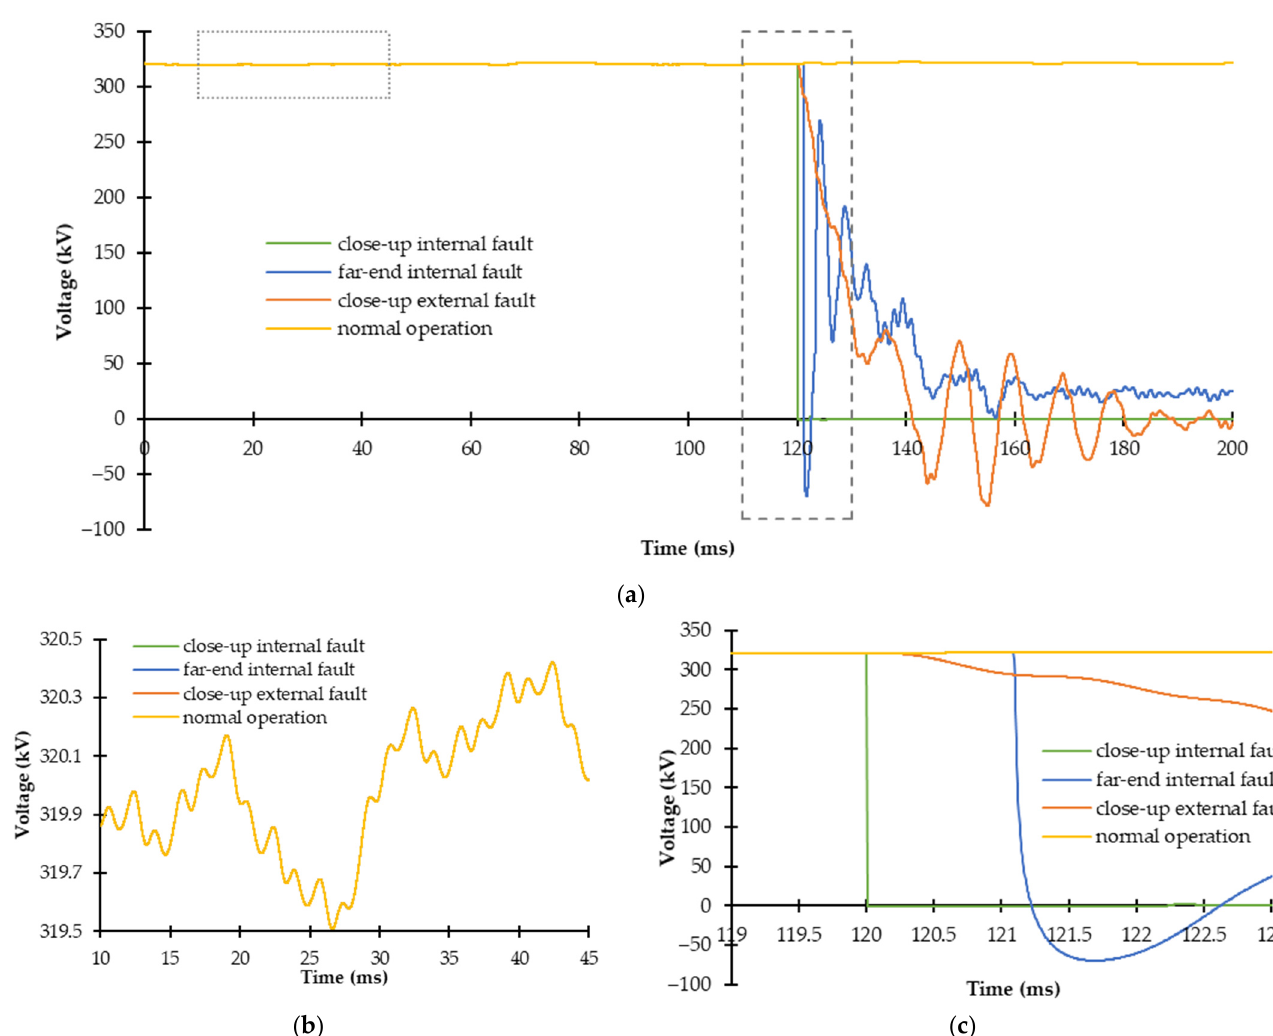
Figure 2. ( a ) Fault-induced DC voltage for different fault conditions, ( b ) voltage in steady-state, zoom in dotted square between 10 and 45 ms, and ( c ) voltage under fault conditions, zoom in dashed line square between 199 and 123 ms.